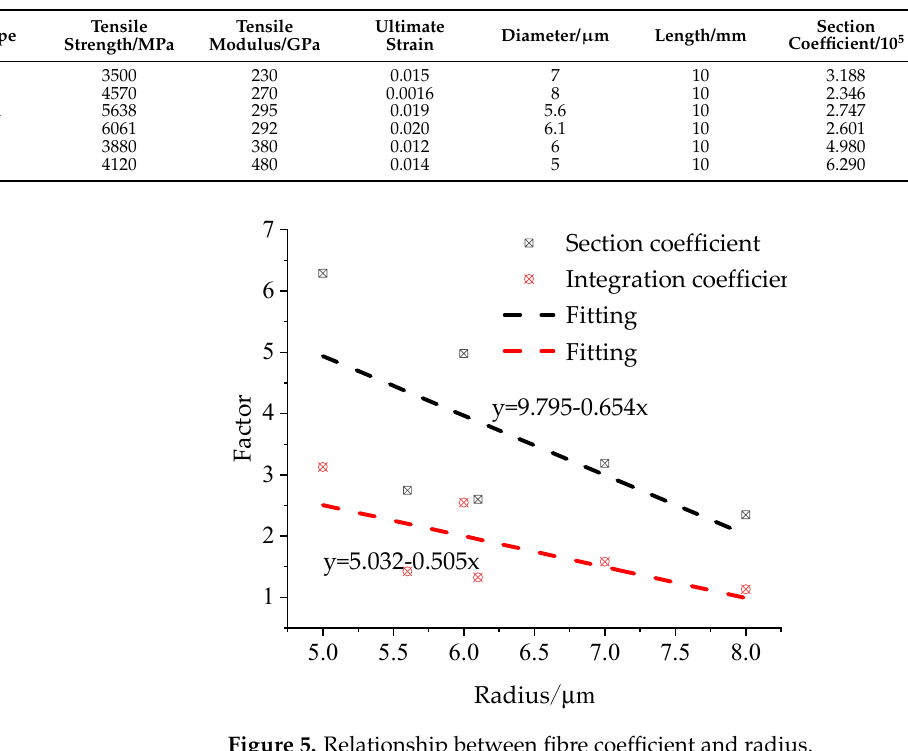
Table 1. Statistics of geometrical parameters of different types of carbon fibre.